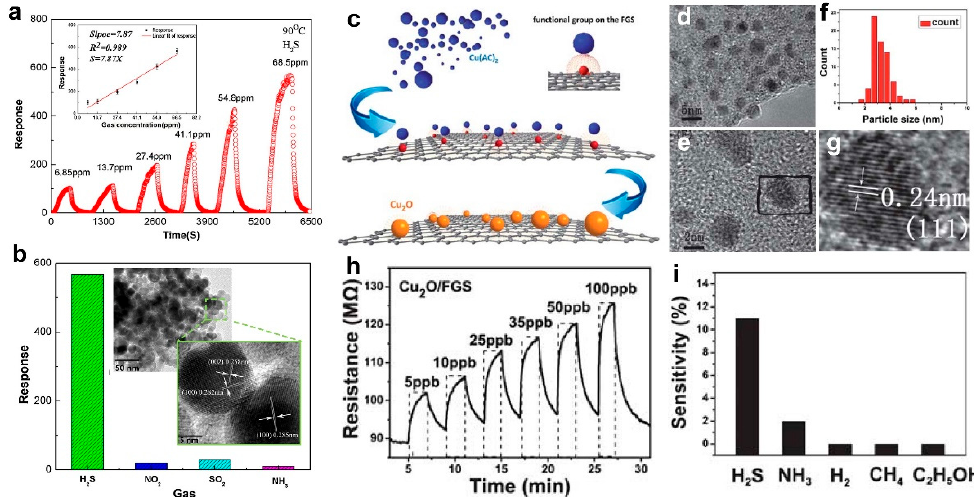
Figure 2. ( a ) ZnO sensing response upon exposure to H 2 S at 90 °C. Inset: the ZnO device demonstrated a linear response behavior towards H 2 S in the concentration range of 13.7 to 68.5 ppm. ( b ) Selectivity towards H 2 S with a negligible response to other gases at concentrations of 68.5 ppm. Inset: TEM images of ZnO nanoparticles with 14.6 nm diameter after annealing at 300 °C [50]. ( c ) The schematic illustration of in situ synthesis of Cu 2 O–FGS. ( d , e , g ) TEM images of Cu 2 O–FGS and ( f ) particle size distribution of Cu 2 O nanocrystals decorated on FGS. ( h ) The dynamic H 2 S sensing behavior of the Cu 2 O–FGS-based sensor device. ( i ) Cu 2 O-FGS sensitivity toward different gases: H 2 S (5 ppb), NH 3 (25 ppm), H 2 (25 ppm), CH 4 (25 ppm), and C 2 H 5 OH (25 ppm) [49].